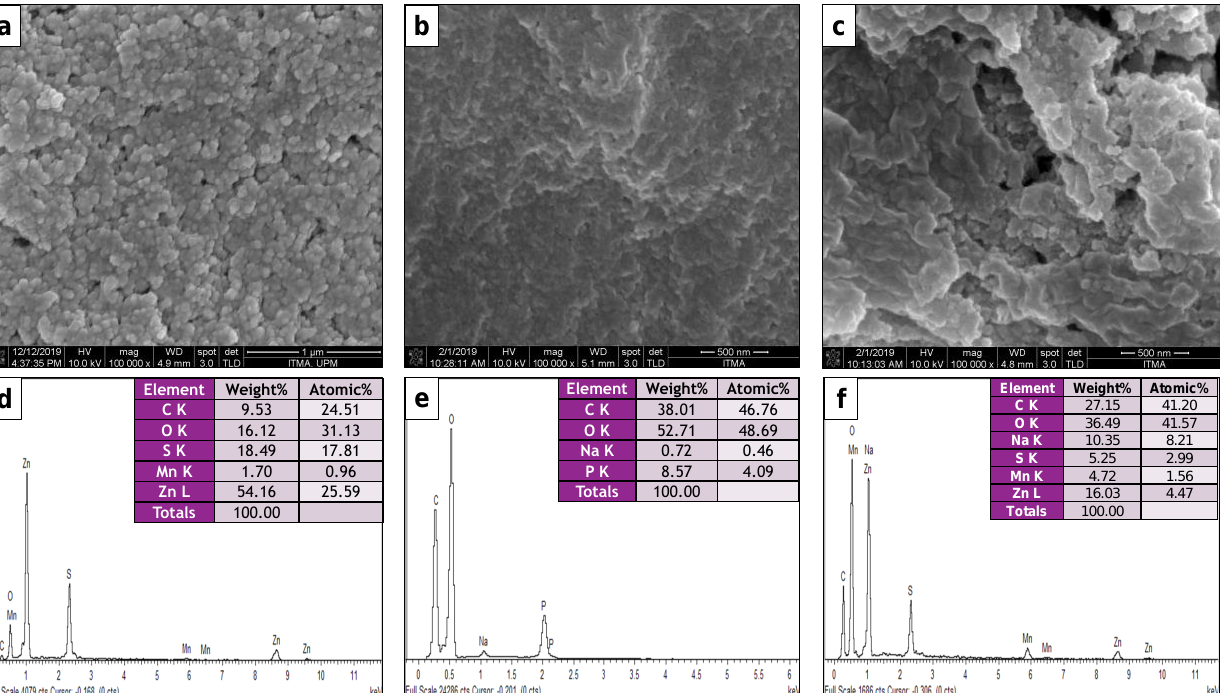
Figure 6. FESEM images for ( a ) Mn:ZnS; ( b ) CS, and ( c ) CS-Mn:ZnS; EDX spectra for ( d ) Mn:ZnS, ( e ) CS, and ( f ) CS-Mn:ZnS nanostructure.